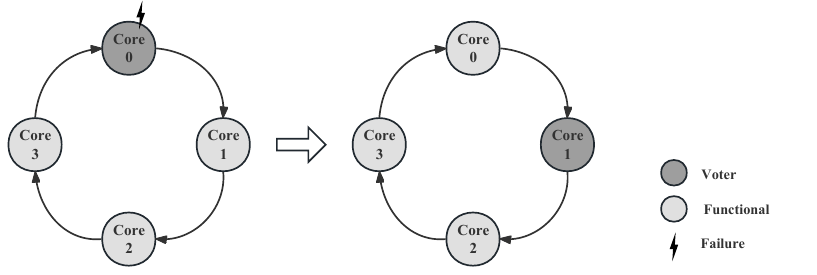
Figure 7. Voter rotation of